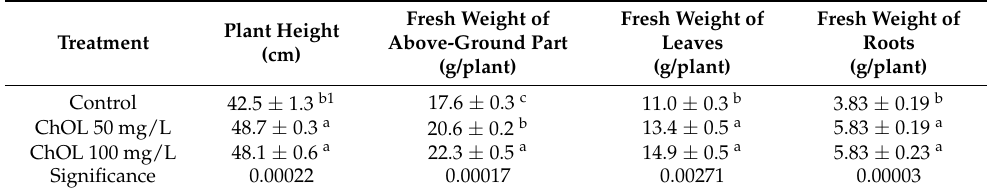
Table 1. Effects of chitosan oligosaccharide lactate (ChOL) on plant height, fresh weight of above- ground part, leaves and roots per plant of red